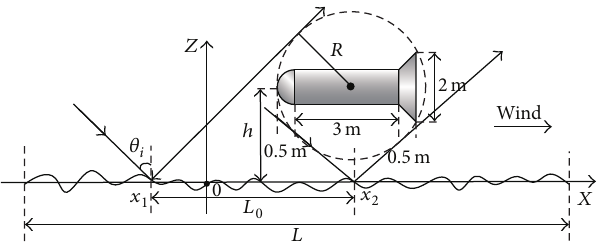
Figure 1: Scattering of the composite model.